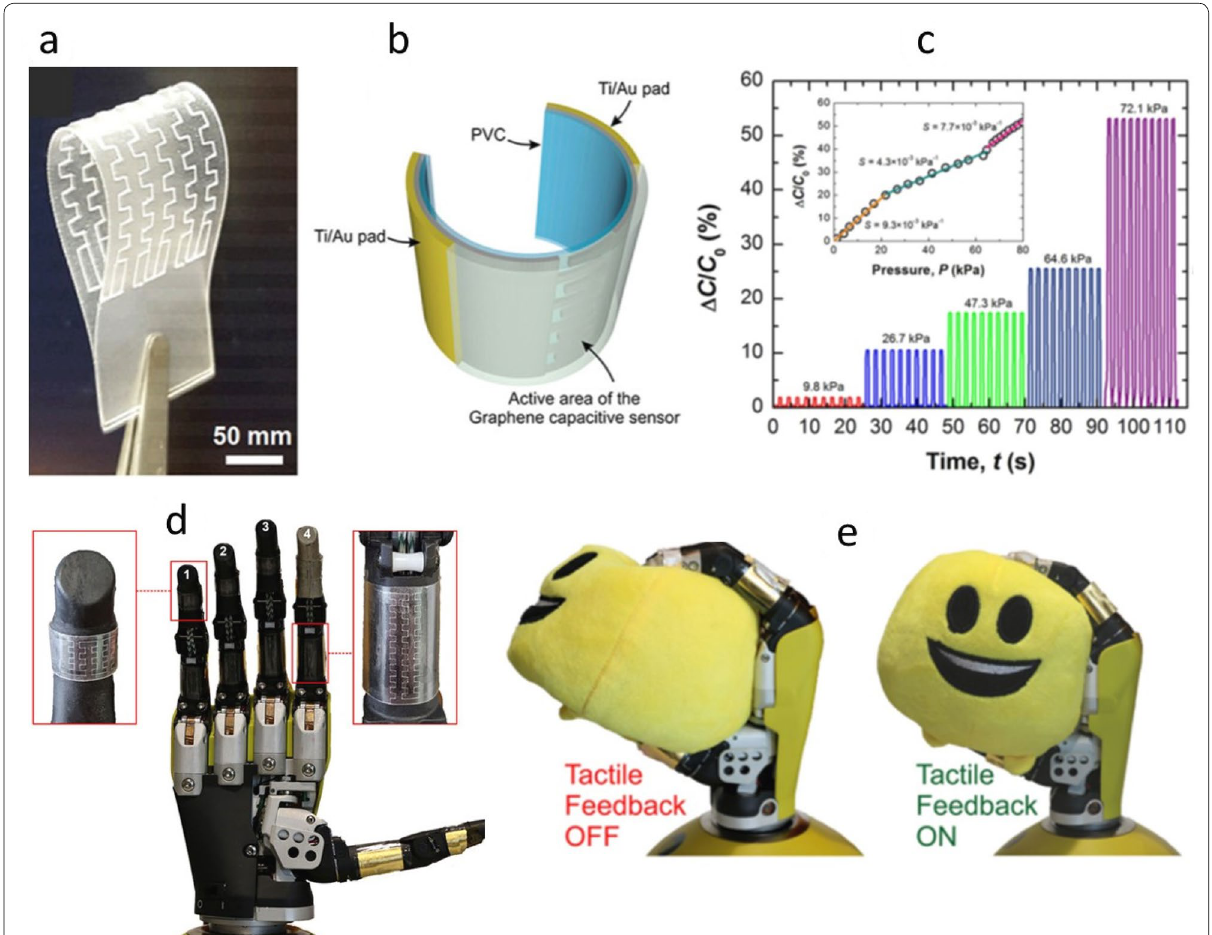
Fig. 13 Large area graphene based capacitive tactile sensors: ( a ) Photograph and ( b ) 3D schema of a flexible graphene capacitive touch sensor. c Touch sensor response vs. applied pressure. d eskin with capacitive sensors integrated onto a robotic hand. e Self-powered eskin used as tactile feedback for a robotic hand. Reprinted with permission from Ref.